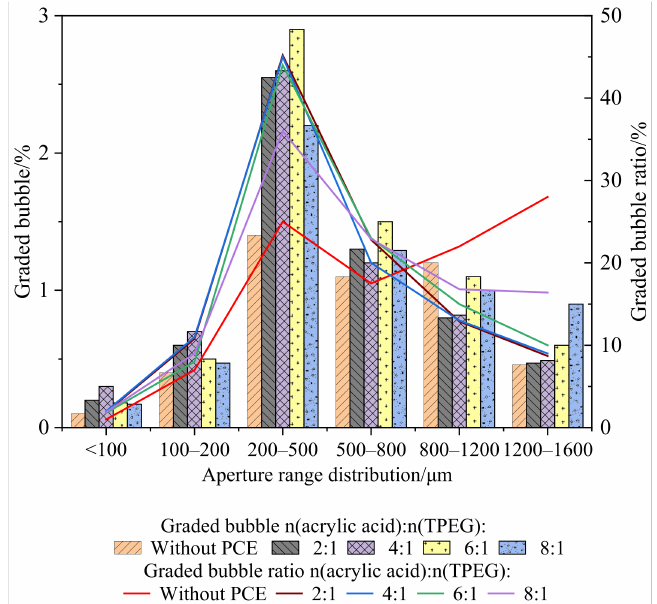
Figure 16. Effect of PCEs with different acid-ether ratios on the pore size distribution of cement mortar